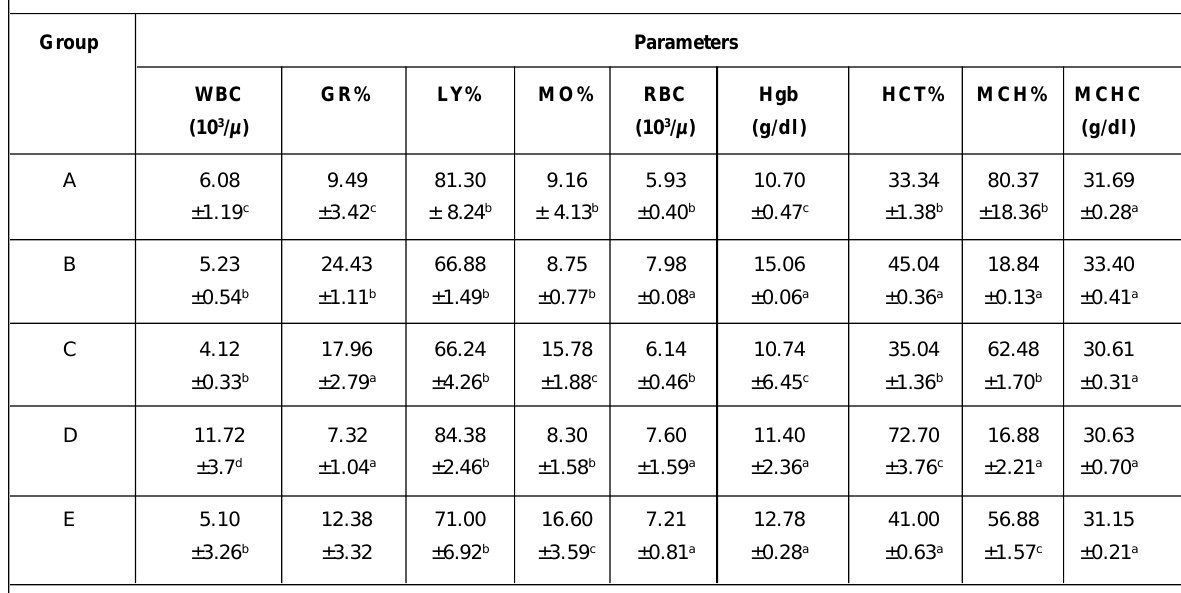
ratsTable Table 3: Effect of M. lucida on the haemotological parameters on lactose induced diarrhea in Wistar